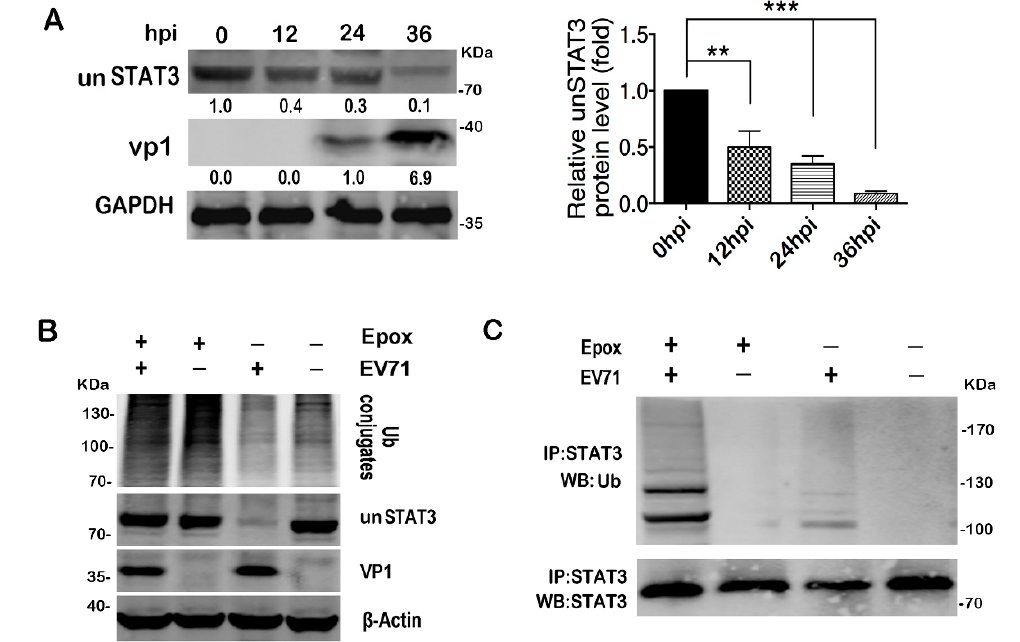
Figure 7. EV71 infection induced proteasome-dependent degradation of un-phosphorylated STAT3. ( A ) unSTAT3 protein levels at indicated time points post infection were determined by western blot. ( B ) Epoxomicin inhibited unSTAT3 degradation post infection. T98G cells were treated with or without 2 µ M epoxomicin (Epox) for 2h and were infected with EV71. Cell lysates were prepared 36 hpi, and Ub conjugates as well as unSTAT3 were analyzed with specified antibodies. ( C ) IP assay was performed with STAT3 specific antibody and the precipitants were analyzed with ubiquitin specific antibody, ** p < 0.01, *** p < 0.001.